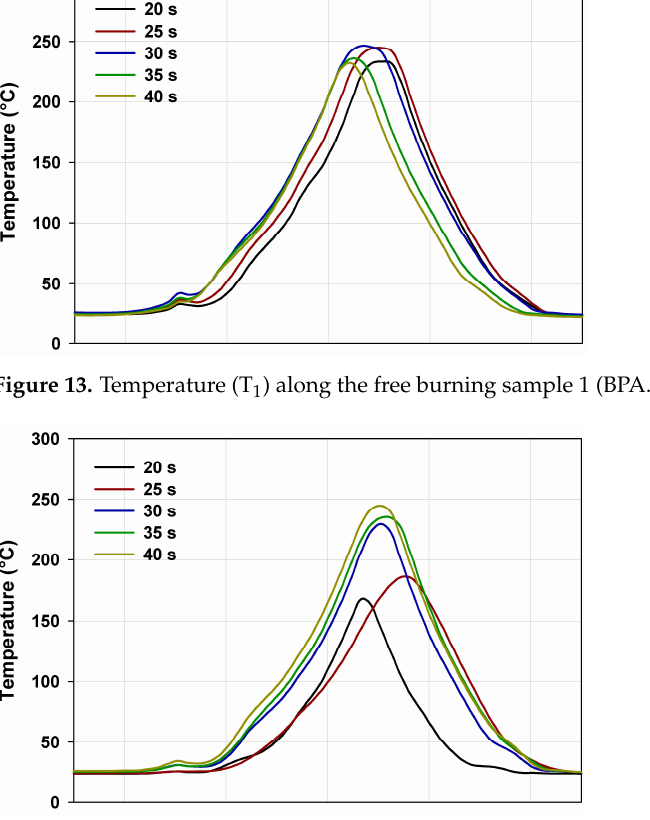
Figure 14. Temperature (T 1 ) along the free burning sample 6 (BPA.DM-NVP-5).